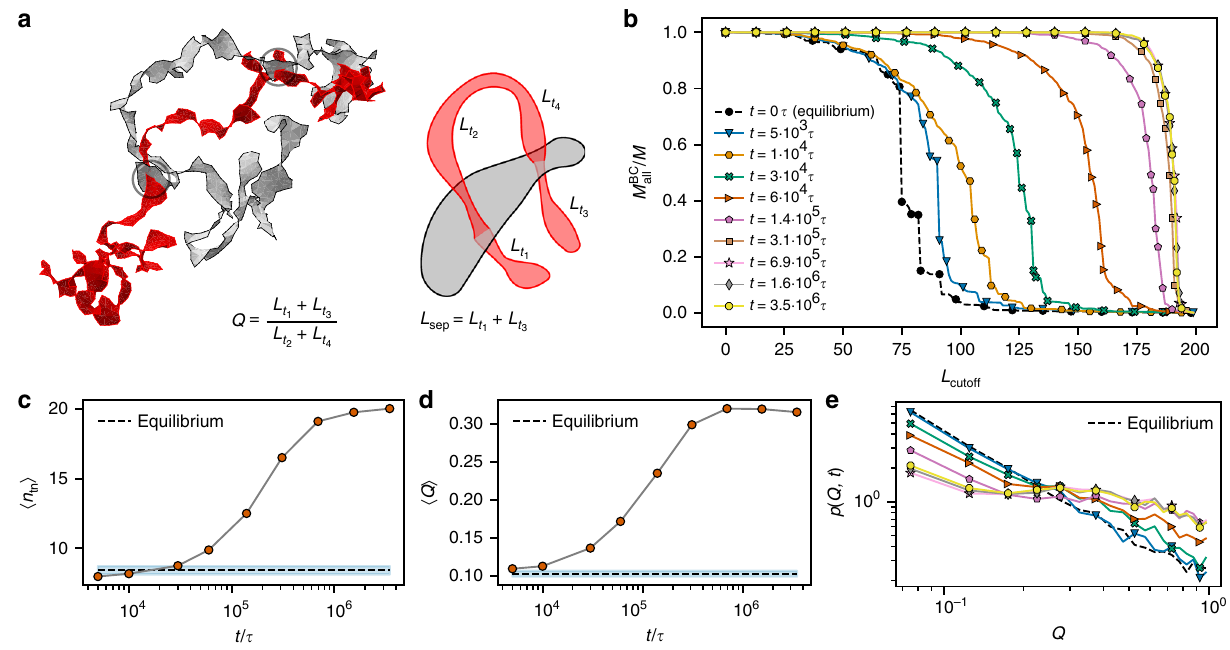
Fig. 5 Threading analysis. a The edgy image is an example of two rings in a steady state and their minimal surfaces (the circles mark the locations of threadings). The schematic smooth image shows the de fi nition of L (measured in the number of monomers) and Q (see text). b Relative size of the sep biggest threading cluster (the number of rings belonging to the biggest cluster, M BC , divided by the total number of rings, M ) as a function of the cutoff all i by a ring as a function of time from the activity onset. The n length L . c Mean number of threaded neighbors h n is computed as the total number of cutoff tn tn threadings in the system n divided by M . d Mean threading length ratio Q as a function of time. e Distribution of Q for different times after the activity th onset (the legend is the same as in b ).